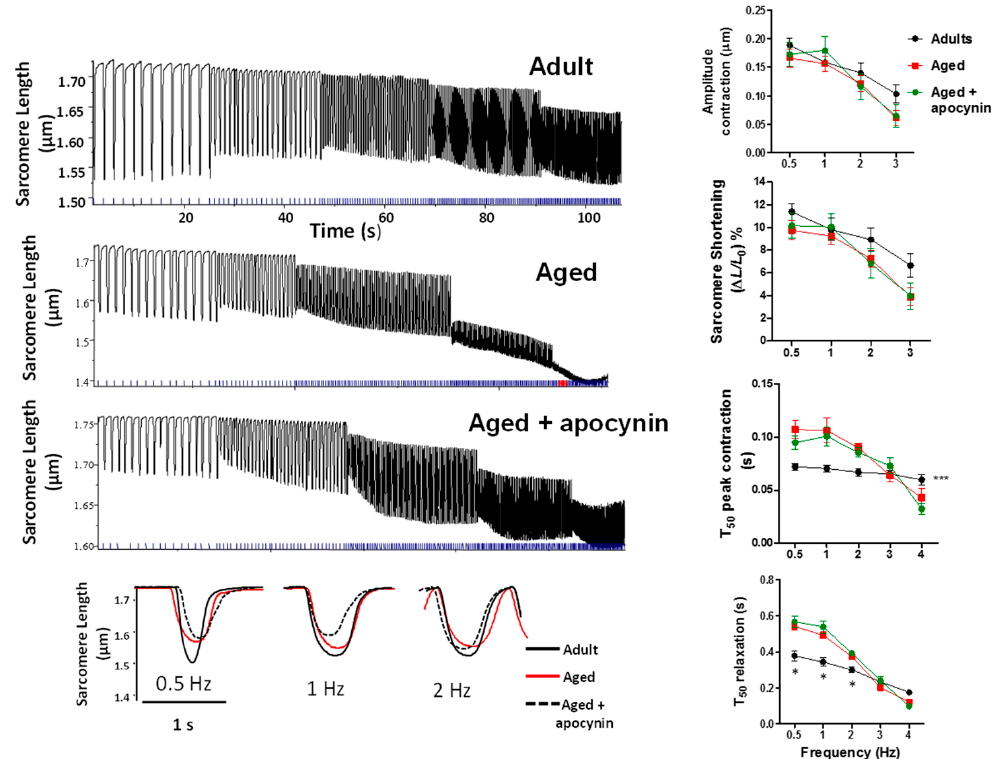
Figure 2. Contractility in isolated myocytes. Isolated cardiomyocytes stimulated at increasing